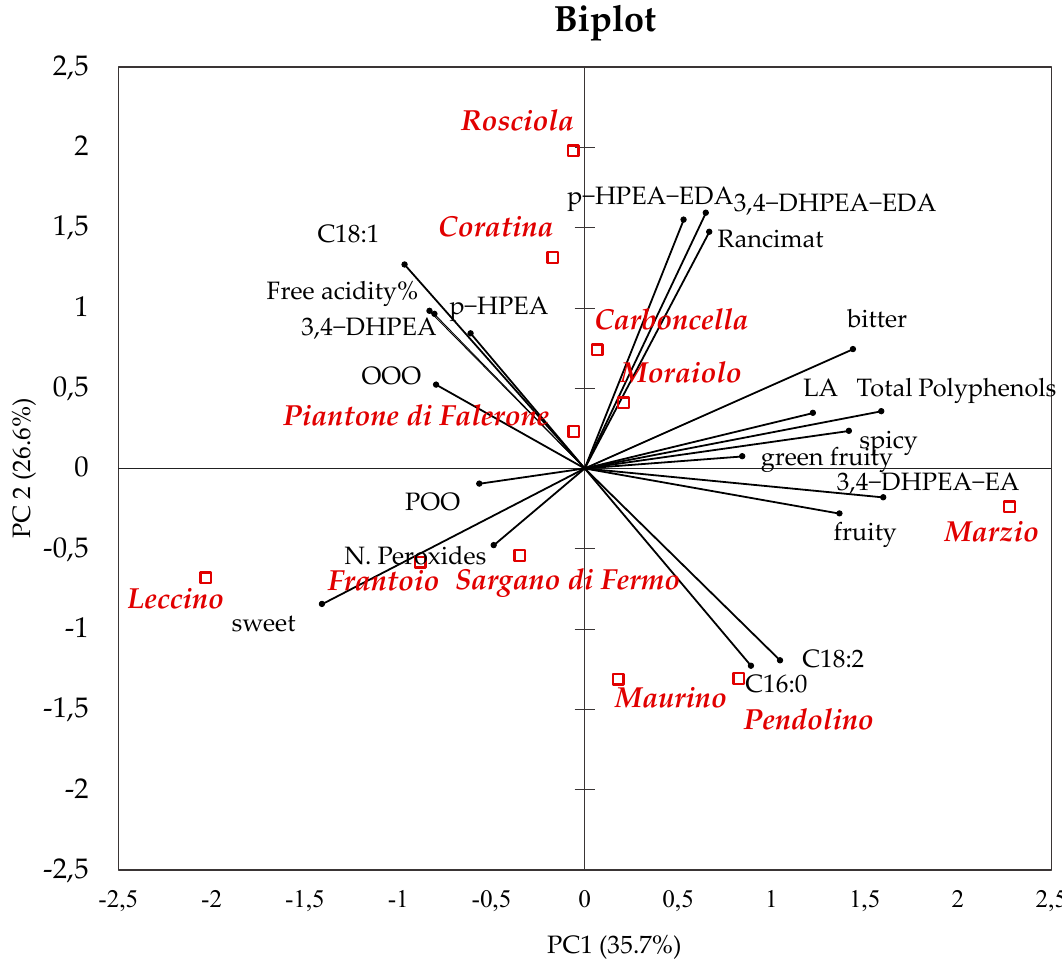
Figure 1. Bi-plot from principal component analysis (PCA) reporting principal components 1 and 2 (PC1 and PC2, respectively) with the loadings of selected chemical and sensory variables and the scores (oil samples).